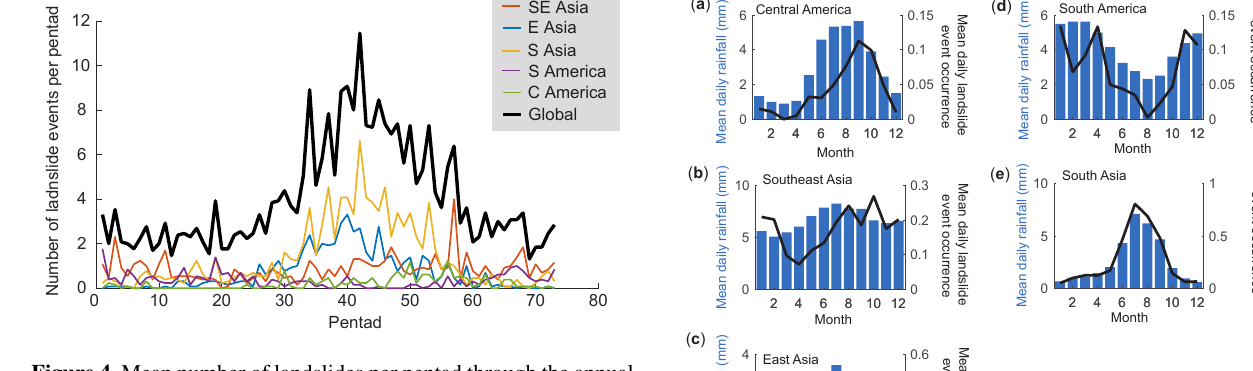
Figure 4. Mean number of landslides per pentad through the annual cycle for all rainfall-triggered landslides, by geographical region. The 20th pentad is the 6–10 April, the 40th pentad is 15–19 July and the 60th pentad is 23–27 October.